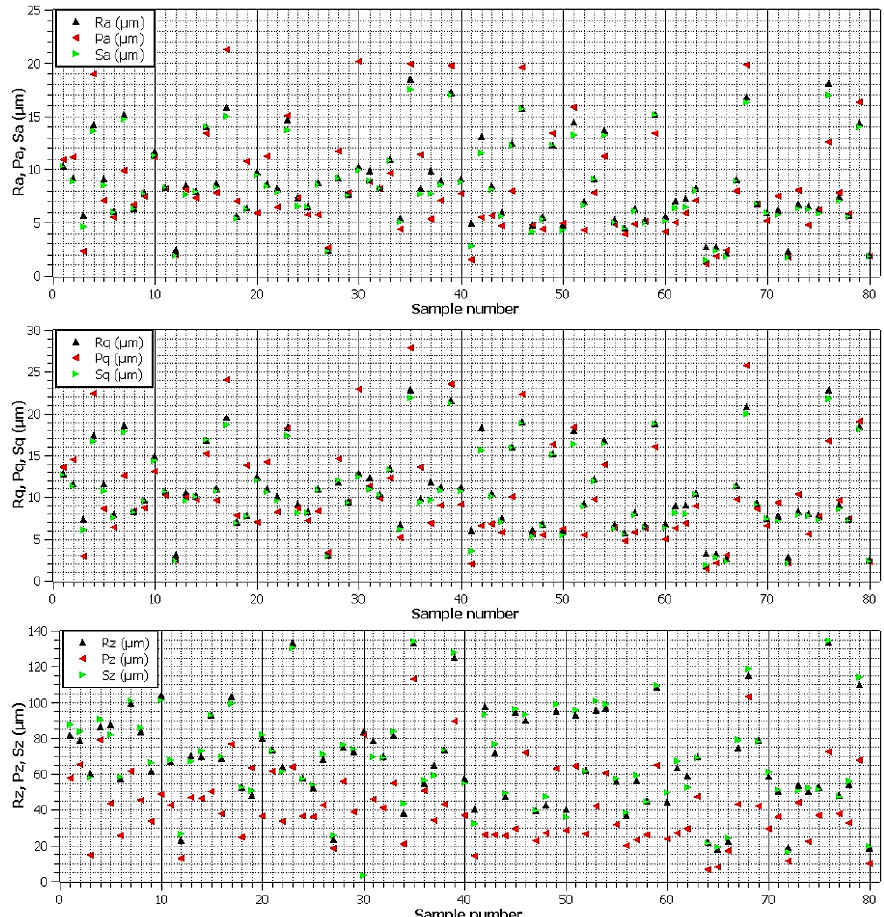
Figure 2. Basic profile parameters, profile, and area parameters of individual experimental samples.